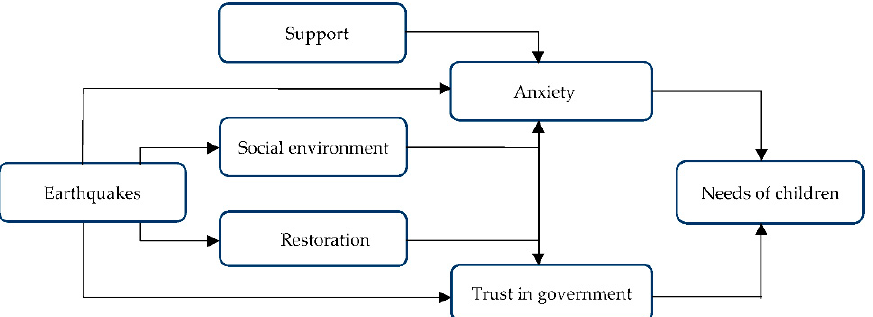
Figure 3. Conceptual model of themes regarding gas extraction earthquakes in Groningen from the perspective of adolescents.